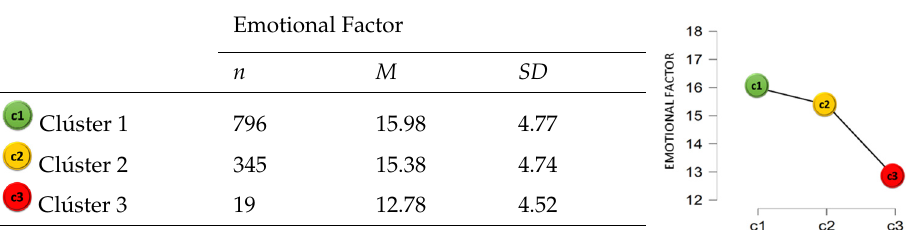
Table 1. Adaptation to change by a COVID-19 cluster, descriptive statistics, and ANOVA.